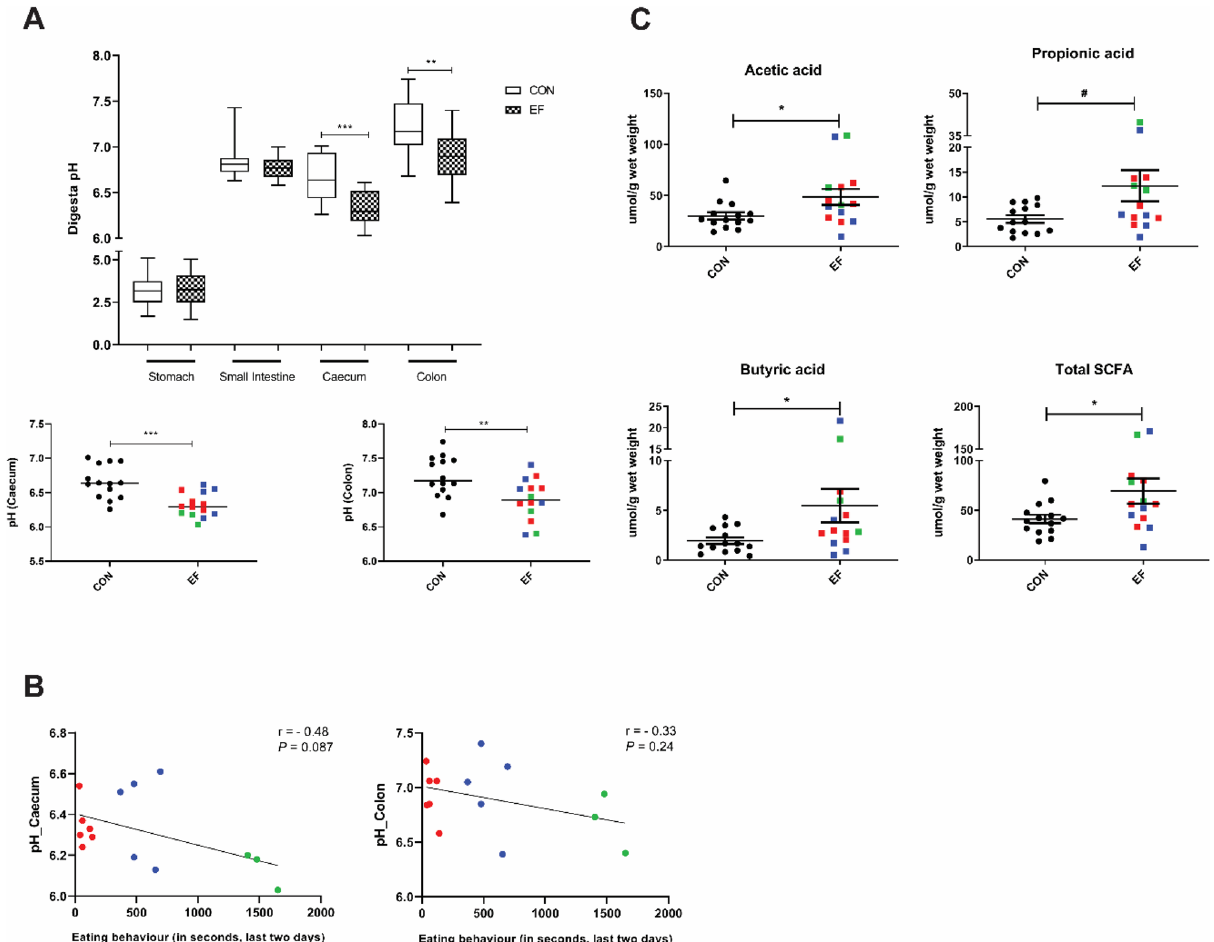
Figure 4. Impact of early feeding on pH and short chain fatty acids (SCFAs). ( A ) Digesta pH in different parts of the GIT for EF and CON and an expansion of the two segments where significant difference in pH was detected, illustrating the distribution of individual piglets in both groups (using the EF group classification of good (green), moderate (blue) and bad (red) eaters; see Fig. 2B). ( B ) Correlation of pH caecum/colon of individual EF piglets with the quantified eating score from last two days (Caecum: r = − 0.48, P = 0.087; Colon: r = − 0.33, P = 0.24). ( C ) Group level comparison for colonic SCFA concentration (µmol/g wet weight of digesta) in piglets. Significant differences between groups were assessed by student t test or Mann–Whitney U test (*: P < 0.05; **: P < 0.01; ***: P < 0.001). EF = early-fed group; CON = control group. Green = good eaters; Blue = moderate eaters; Red = bad